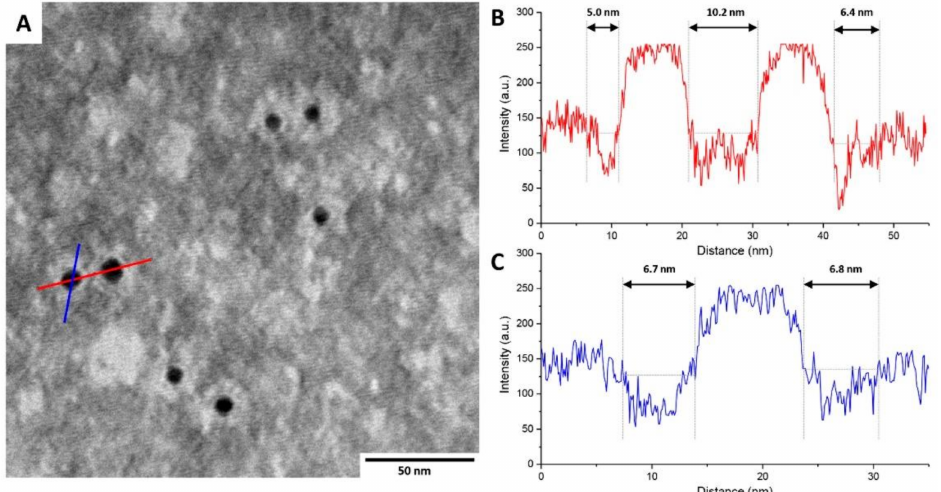
Figure 4. ( A ) TEM image of AuNP2 fully passivated with avidin stained with uranyl acetate. The protein corona is clearly visible as a lighter ring surrounding the dark nanoparticles. ( B , C ) Color intensity analysis across the red ( B ) and blue ( C ) lines of TEM image on the